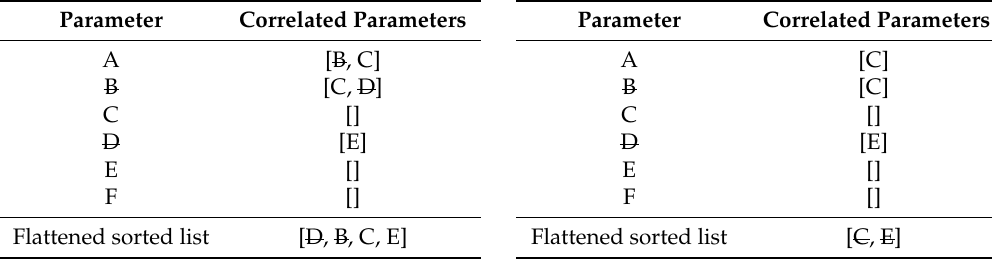
Table 5. Example step 3 in correlation analysis: (left) step a ; (right) step b .